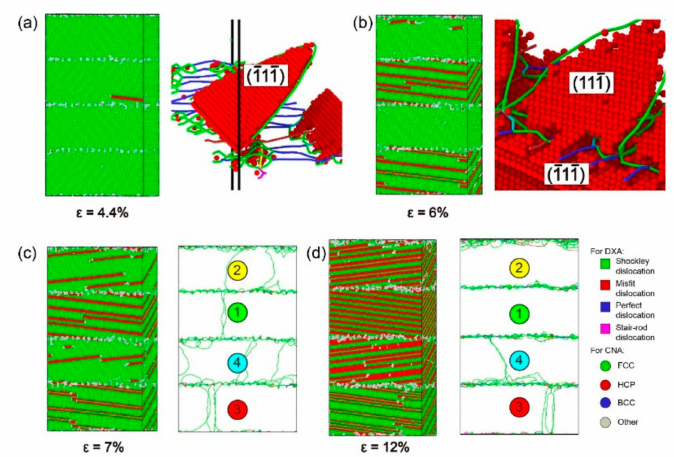
Figure 9. Common neighbor analysis (CNA) and dislocation analysis (DXA) of the model with α = 80 ◦